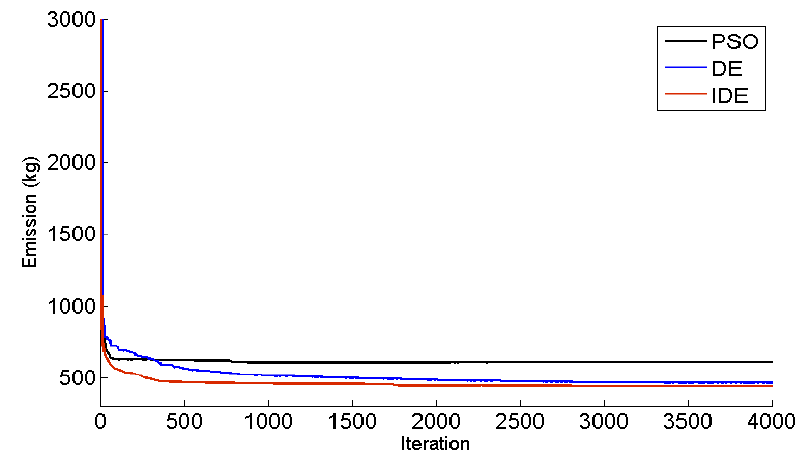
Figure 4. Cost convergence in different methods considering the limitations of power exchange with upstream network.